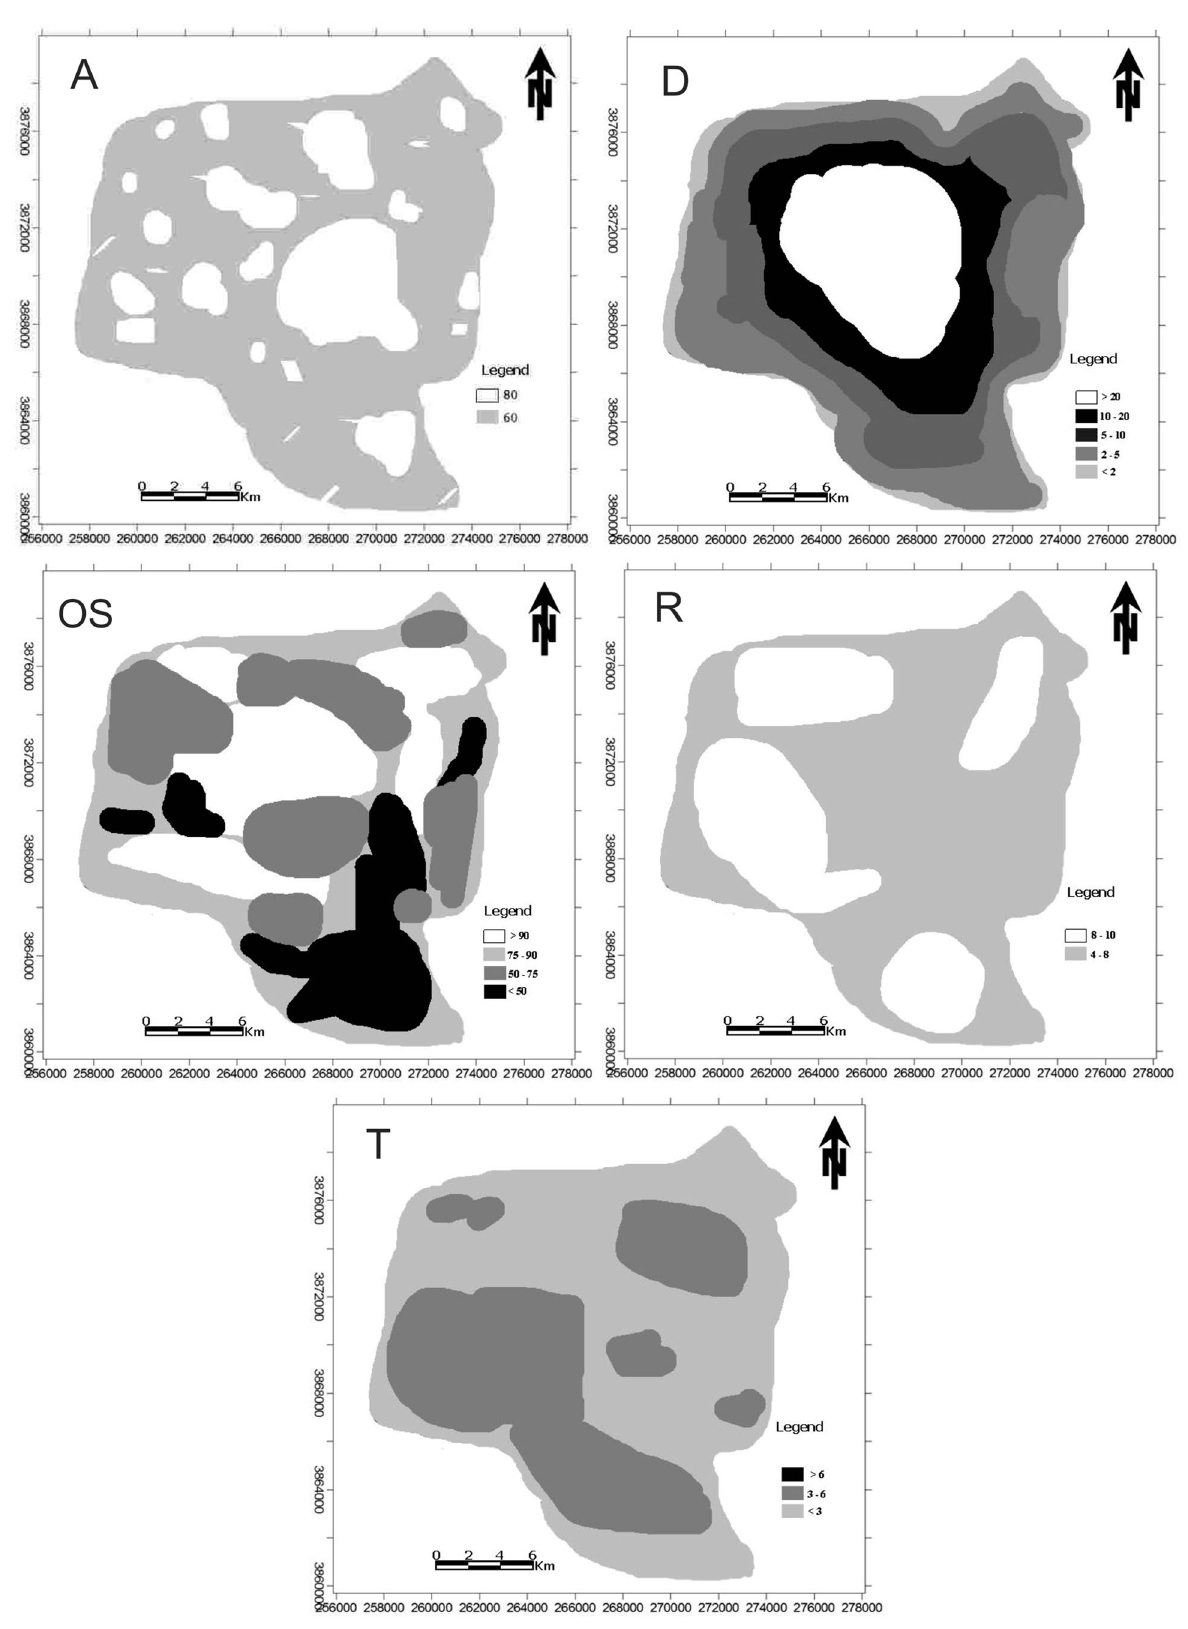
Fig. 6 Mapping of SI model